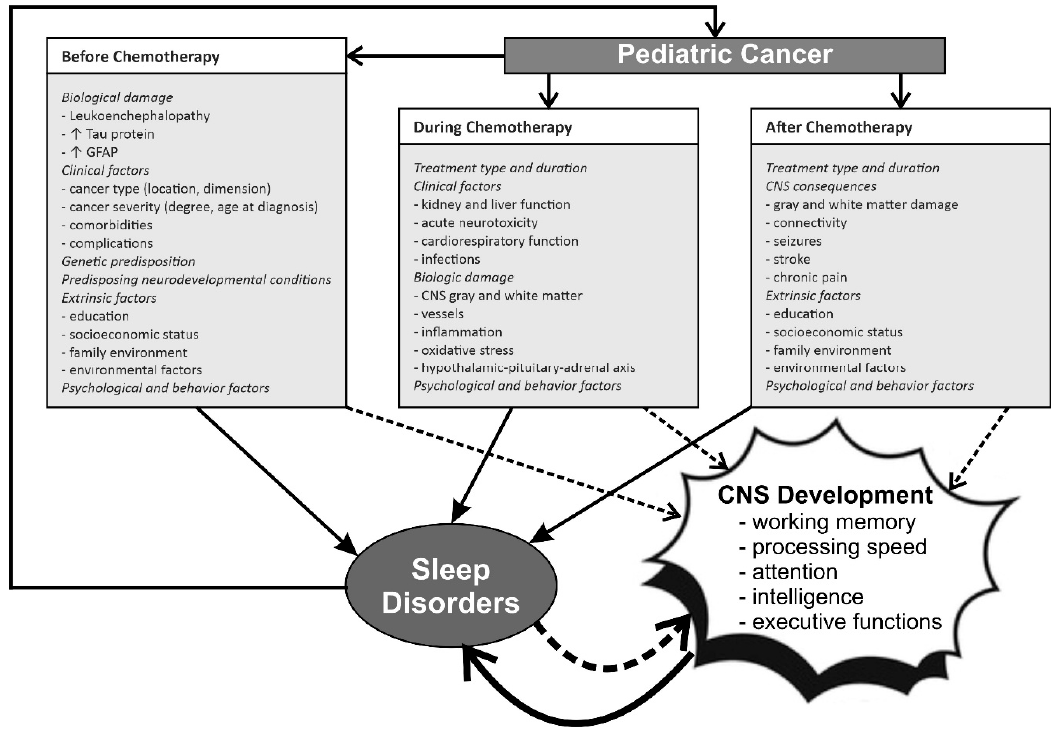
Figure 1. The complex relationship between pediatric cancer, chemotherapy, CNS development and sleep before, during, and after treatment. GFAP, glial fibrillary acidic protein. ↓ decrease; ↑ increase.